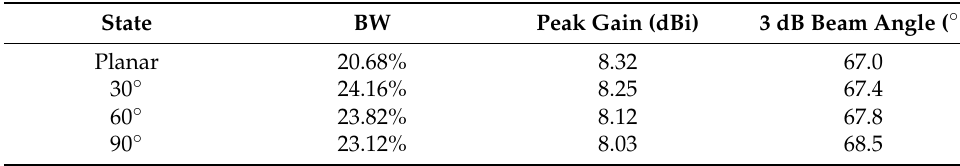
Table 2. Performance characteristics of the proposed antenna